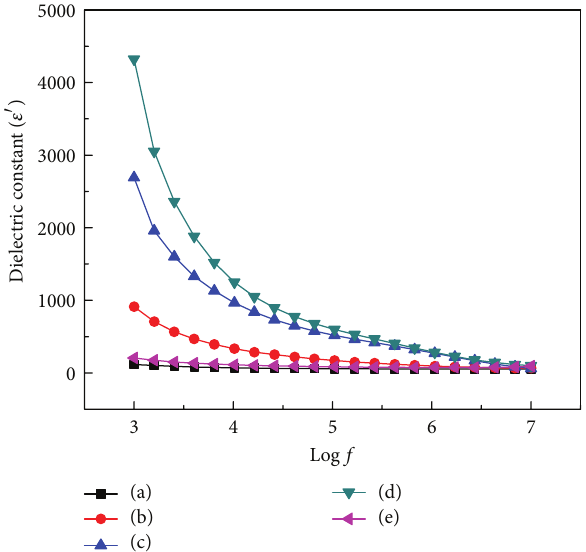
Figure 5: Dielectric constant as a function of frequency for (a) 1wt% Ppy/TiO 2 , (b) 2wt% Ppy/TiO 2 , (c) 3 wt% Ppy/TiO 2 , (d) 4wt% Ppy/TiO 2 , and (e) 5wt% Ppy/TiO 2